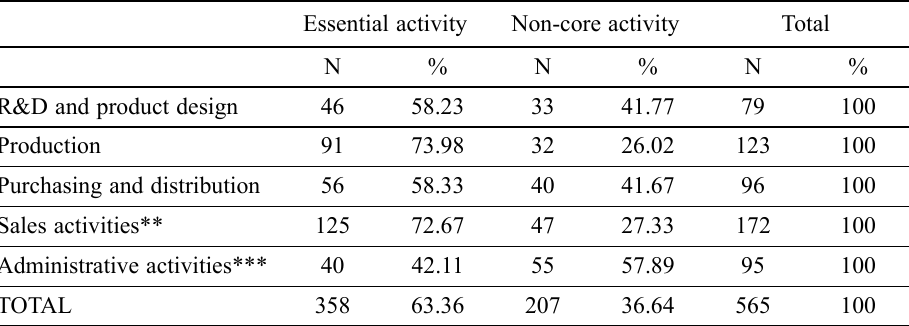
Table 2. Distribution of the dependent variable, by activity (number of offshoring